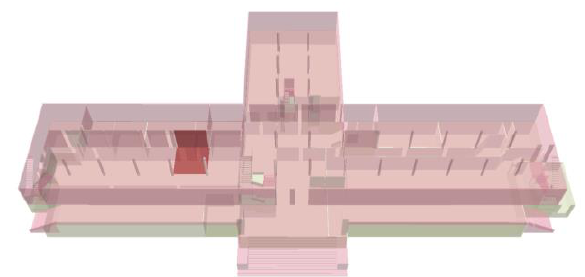
Figure 30. Obstruction Scenario in the General Reference Section